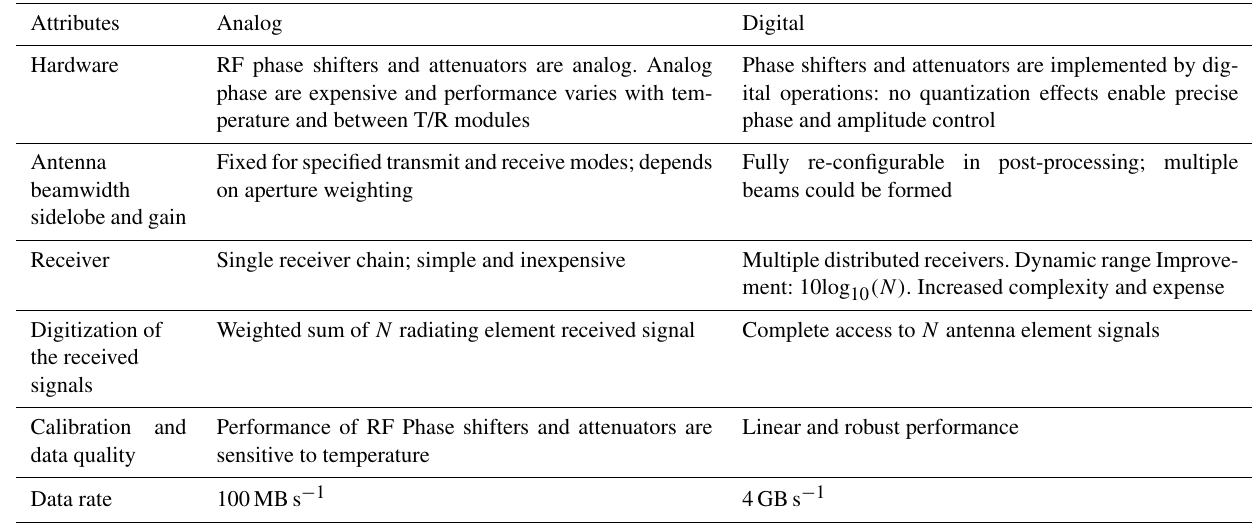
Table 2. Comparison between analog and digital